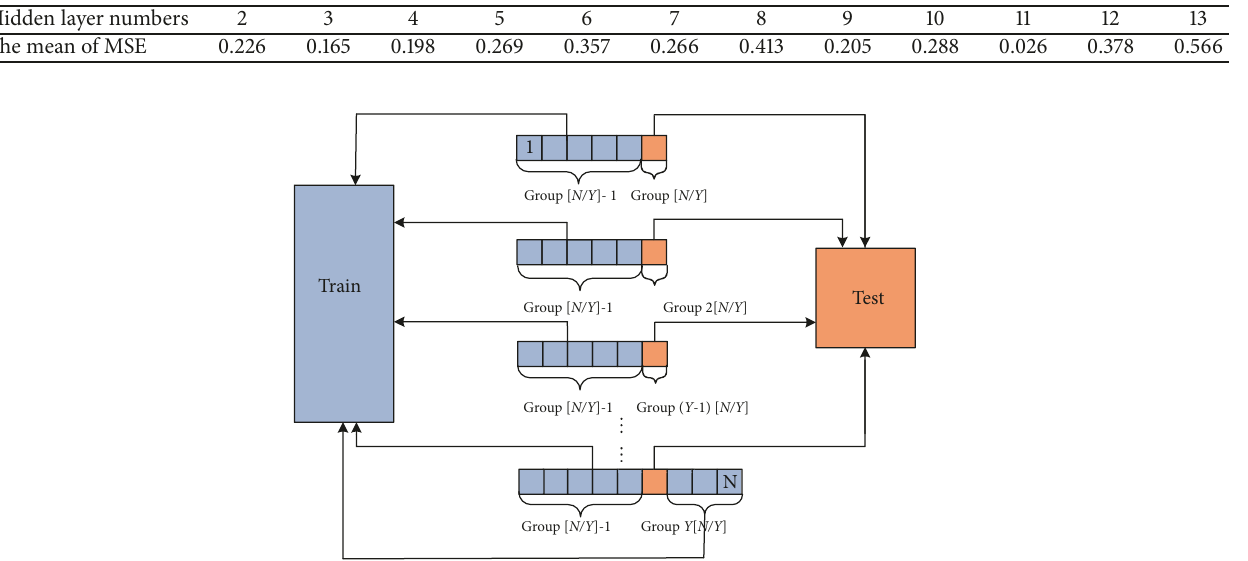
Table 4: The results of trial and error.